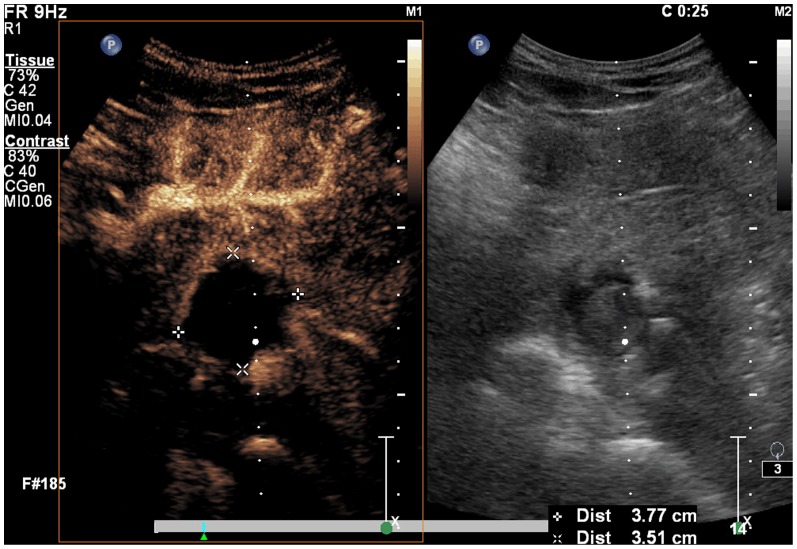
A spherical lesion with decreased volume and low blood flow.Three months after treatment the spherical lesion's volume decreased significantly, and there is no reinforcement of blood flow at the lesion with strengthening in tissues surrounding the lesion.